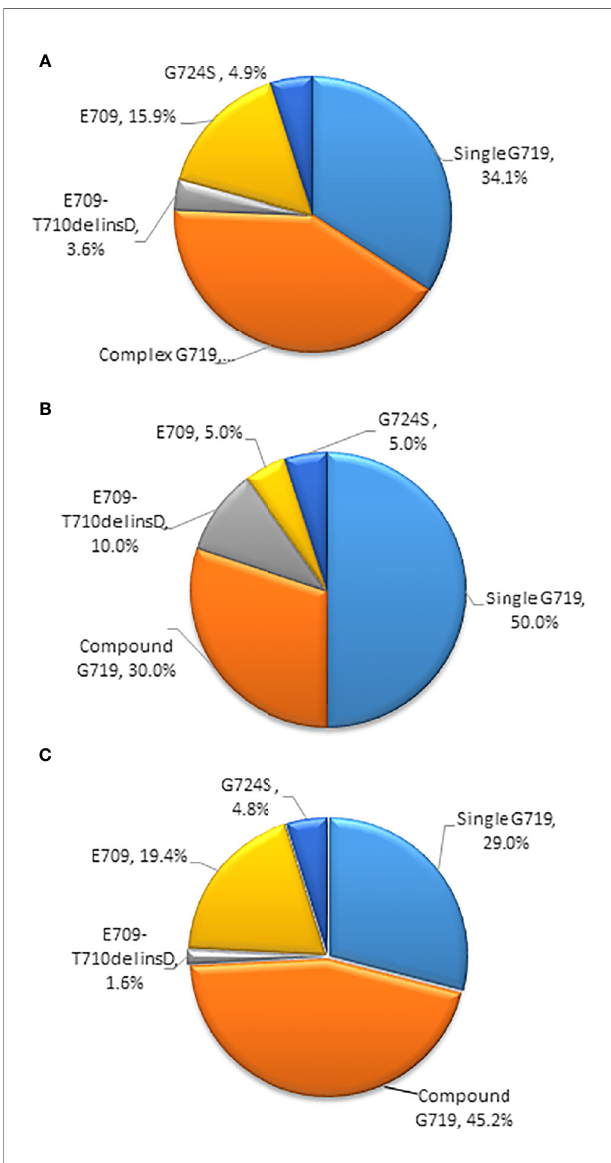
FIGURE 1 | (A) Percentages of subtypes of EGFR exon 18 mutations among all patients (B) Percentages of subtypes of EGFR exon 18 mutations with brain metastases (C) Percentages of subtypes of EGFR exon 18 mutations without brain metastases. ( EGFR , epidermal growth factor